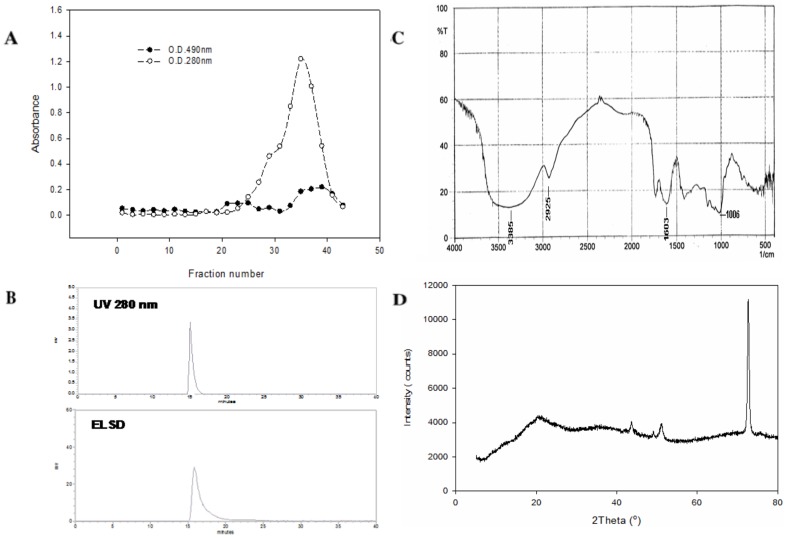
HPLC chromatographic analysis of the ethanolic extract of S. chinensis fruits.The retention times for the dibenzocyclooctadiene lignans were: gomisin C (GmC), 19.17 min; deoxyschisandrin (SA), 29.07 min; schisandrin B (SB), 31.69 min; gomisin O, 8.13 min; schizandrol B, 10.56 min; and gomisin R, 13.85 min, respectively.